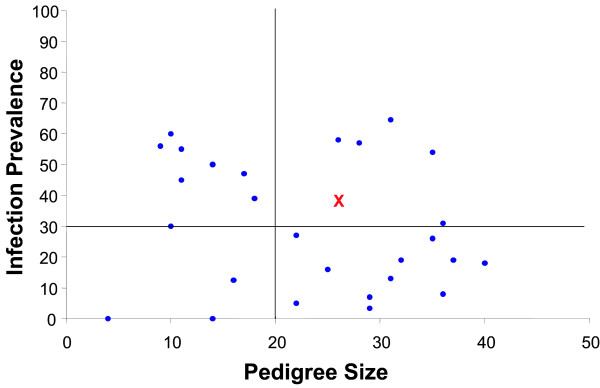
Pedigree criteria for genetic analysis. Pedigrees were chosen for genome-wide genotyping and linkage analysis based on unbiased criteria of infection prevalence (the percent of mosquitoes with at least one midgut oocyst) and pedigree size. These criteria, previously applied in the West African pedigree study [4], prioritize the full analysis of the potentially most informative pedigrees. Pedigrees with ≥20 mosquitoes were analysed (actual range 25–36) and ≥30% infection prevalence (actual range, 31–64%). Only 6 of 28 pedigrees met this criterion, shown in the upper right quadrant. Pedigrees falling outside these boundaries are unlikely to yield a detectable genetic signal, even if segregating strong alleles for resistance/susceptibility. The horizontal line inside the graph indicates 30% prevalence and the vertical line indicates a pedigree size of 20. The red x indicates the pedigree that gave a significant linkage signal.